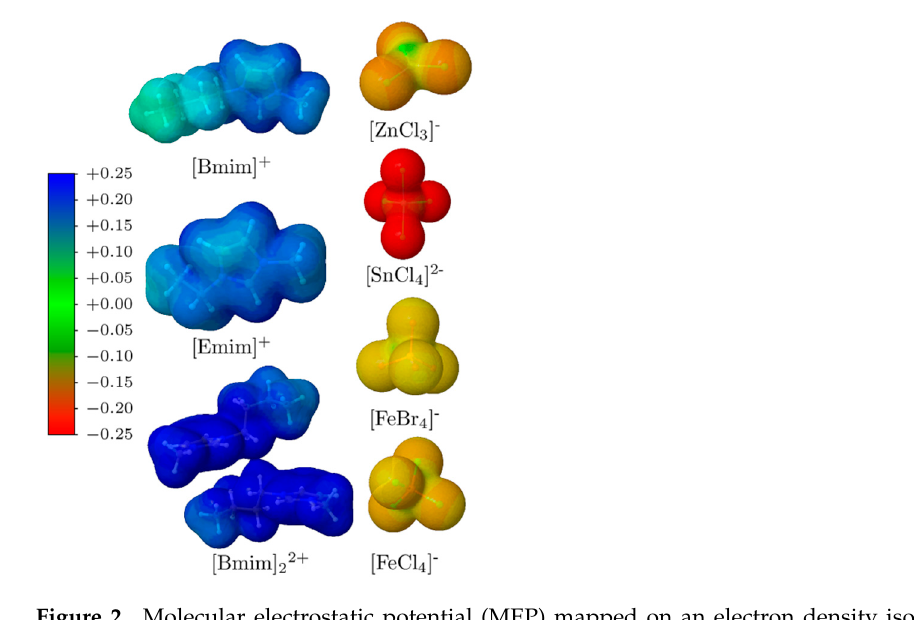
Figure 2. Molecular electrostatic potential (MEP) mapped on an electron density isosurface of 0.004 a.u. for the different fragments in MILs.